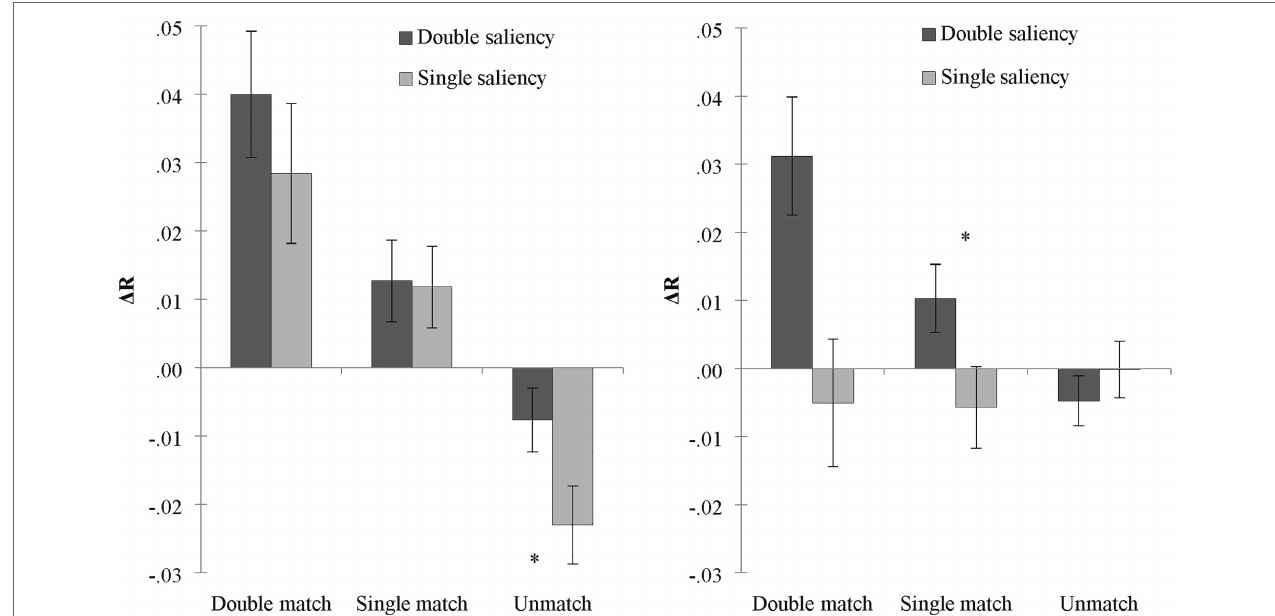
FIGURE 3 | The RT differences of judgments under the conditions of single and double salience in Experiment 1 (left) and Experiment 2 (right). ∗ p <